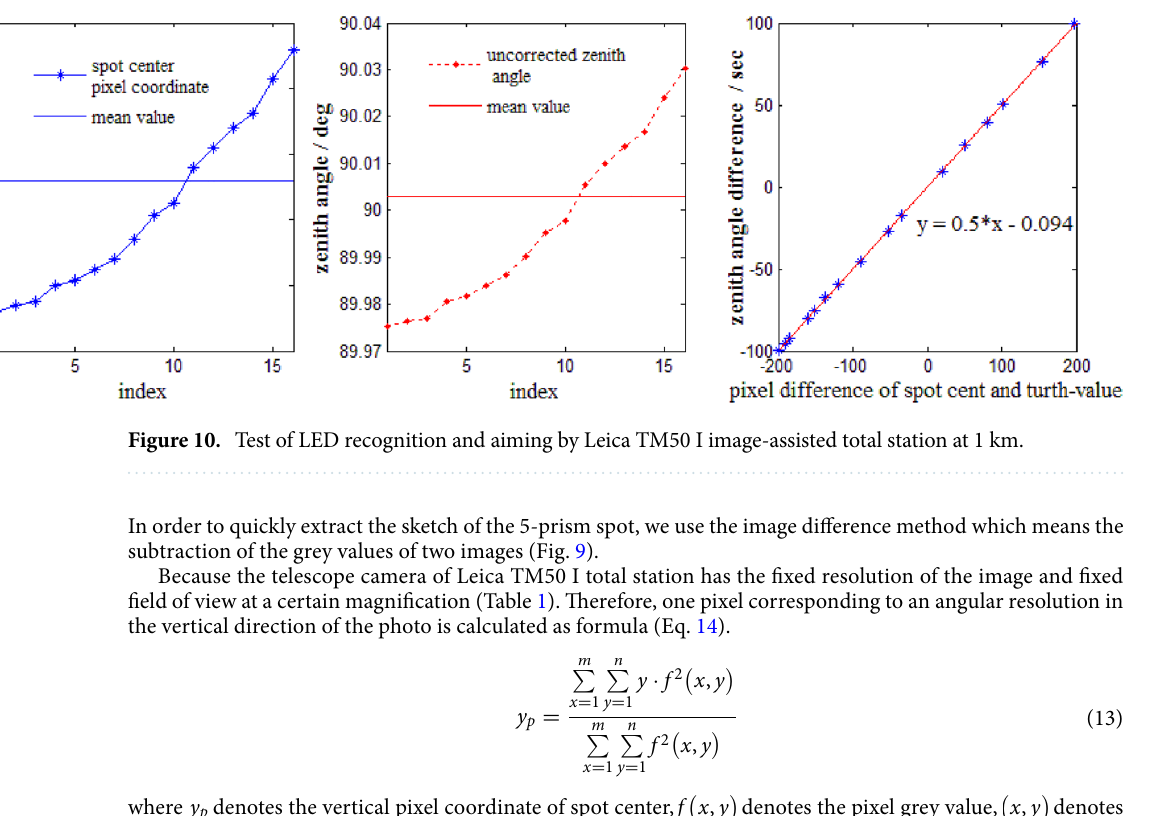
Figure 9. Extraction of LED spot by image difference method.